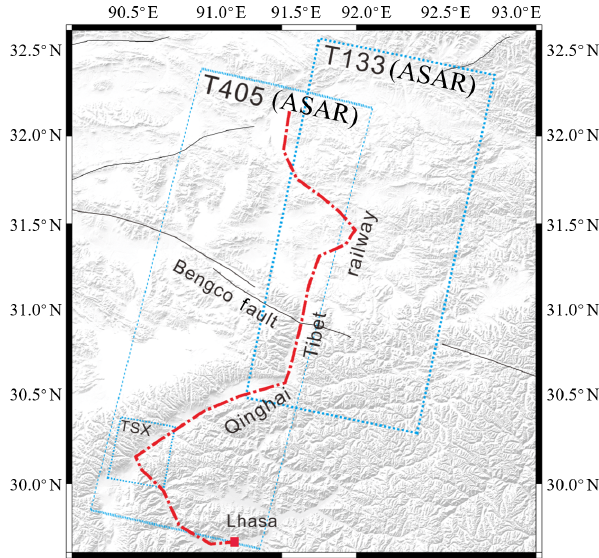
Figure 2. Study area and the distribution of the SAR imagery. The base map is derived from a digital elevation model (DEM). The blue dotted line shows the extents of the ASAR and TerraSAR-X images, T405 and T133 represent the coverage of ASAR data, and the TSX represents the coverage of TerraSAR-X data. The red dotted line shows the railway. The black line shows the main fault in this